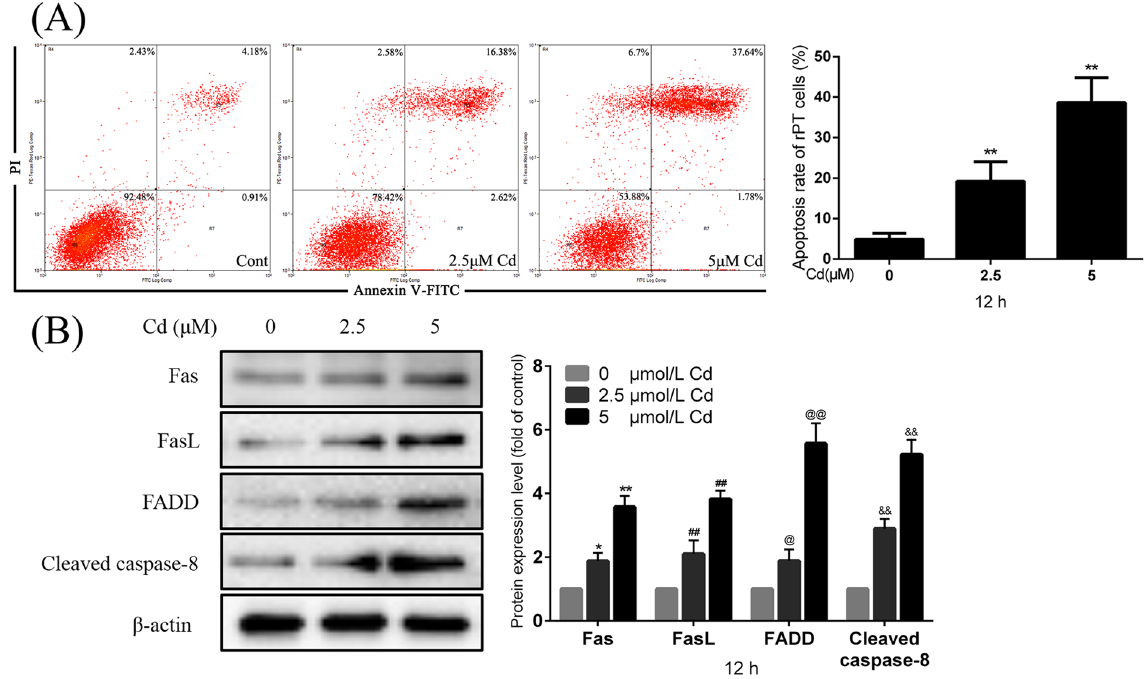
Figure 1. Effects of Cd on Fas/FasL signaling apoptosis pathway activation in rPT cells, measured by flow cytometry and western blot. (A) Cells were incubated with 0, 2.5 and 5 μ M Cd for 12 h, and apoptosis markers were assessed using flow cytometry. Data are mean ± SEM of three separate experiments and each one performed in triplicate (n = 9). (B) Fas, FasL, FADD, and cleaved caspase-8 protein levels were assessed in rPT cells by western blot analysis after 12 h Cd treatment. The quantitative analysis was performed on the western blot results of four independent experiments (mean ± SEM, n = 4), respectively. * P < 0.05, ** P < 0.01, ## P < 0.01, @ P < 0.05, @@ P < 0.01 and && P <